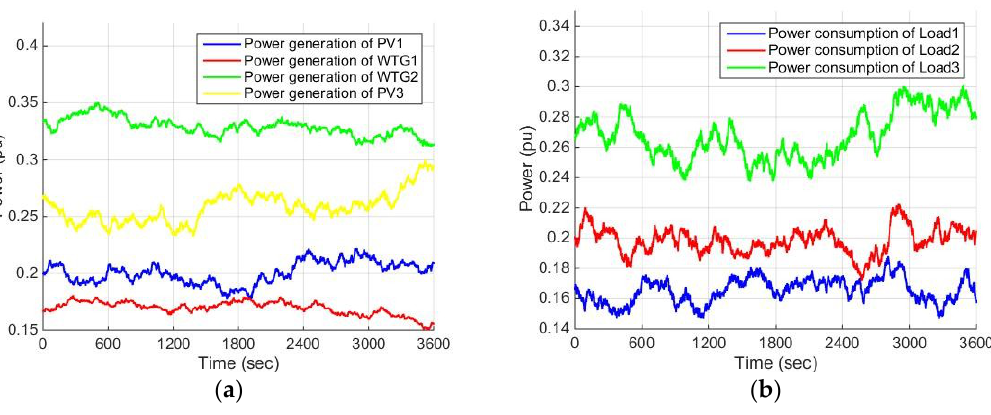
Figure 8. Local power generation and consumption; ( a ) power generation of photovoltaic (PV) units and wind turbine generator (WTGs); ( b ) power consumption of loads.